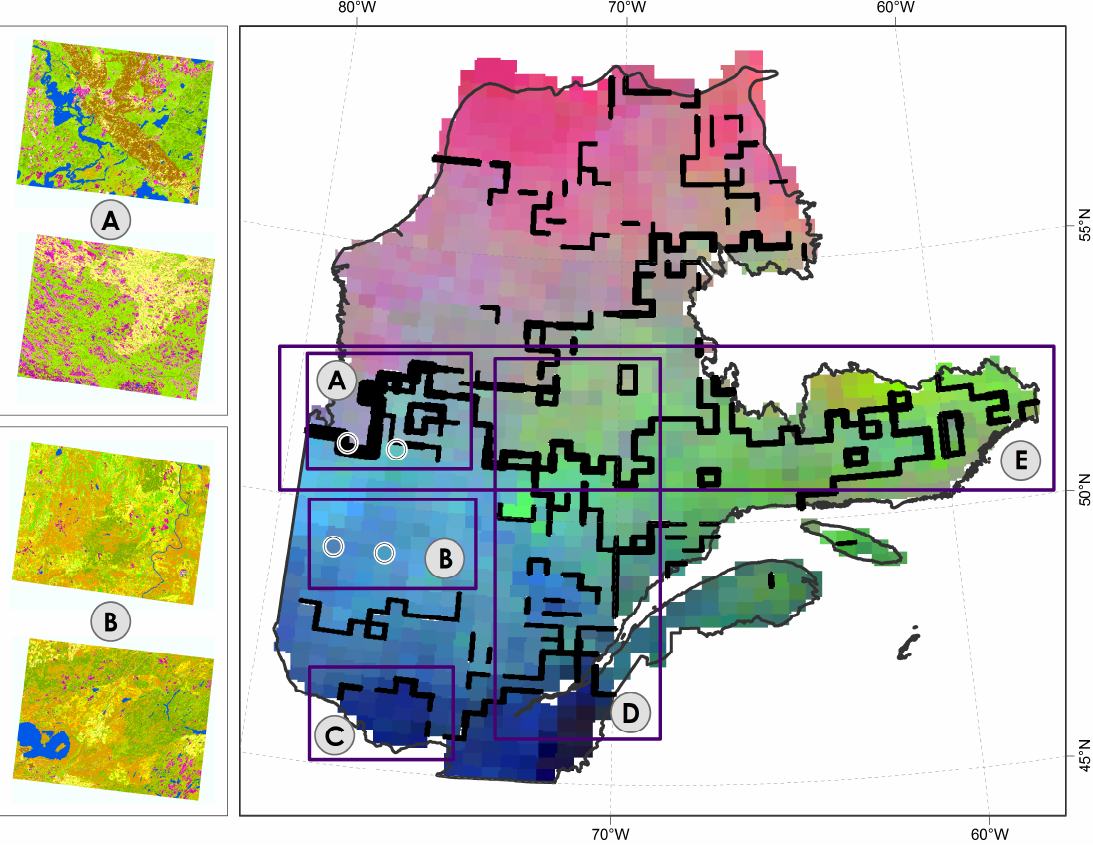
Figure 5. Spatial fences in forested Quebec. Borders between clusters across iterations reveal the most and least pronounced variation among adjacent landscapes in forested Quebec. Thickness of fences represents the degree of magnitude in pattern dissimilarities: thicker fences locate more important changes, and gaps locate gradual changes in landscape